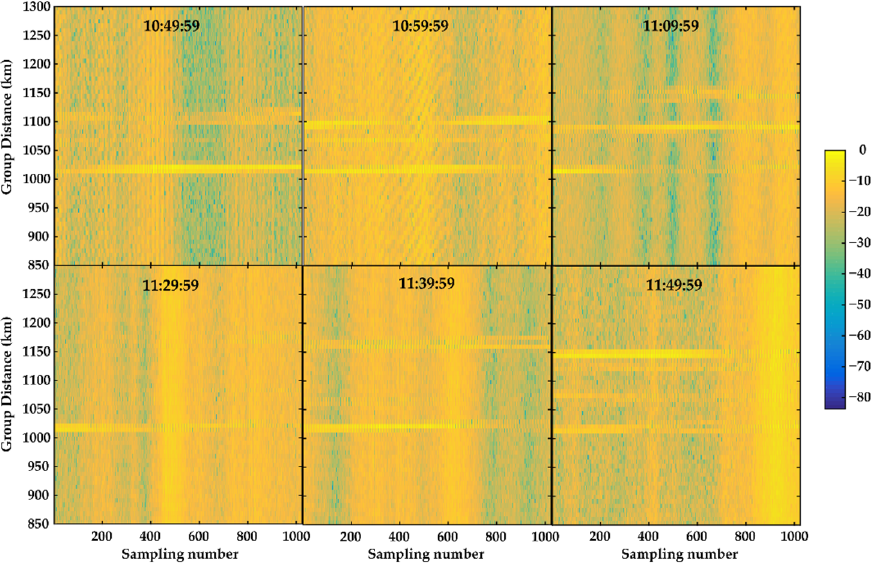
Figure 14. The OIS ionogram of a single channel from 10:49:59 to 11:49:59.